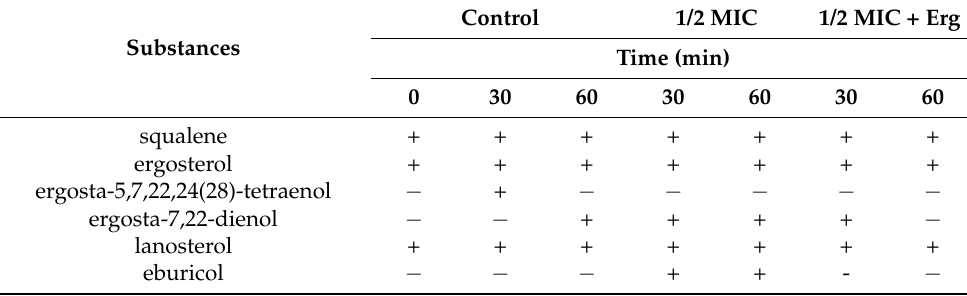
Table 3. Effects of citronellal on the sterols composition of P. digitatum by GC ‐ MS.